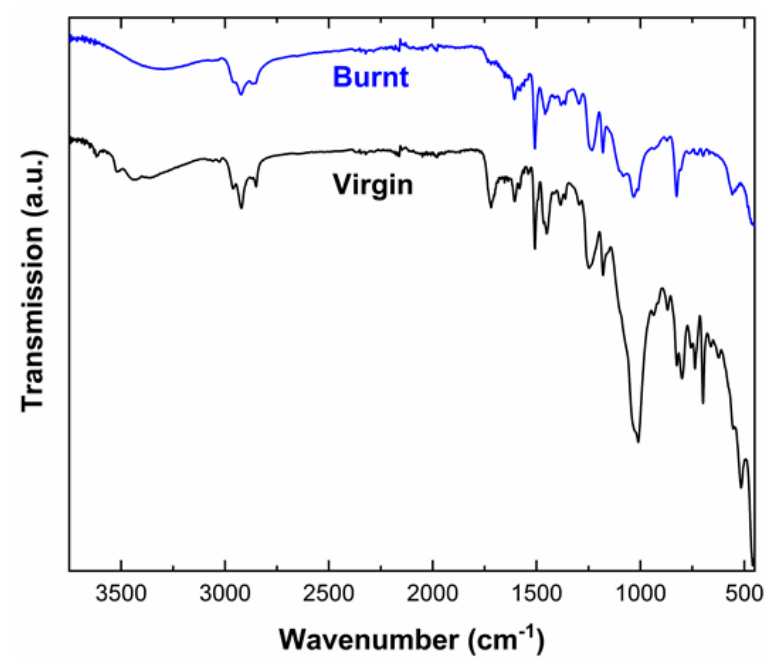
Figure 4. FTIR transmission of virgin and burnt